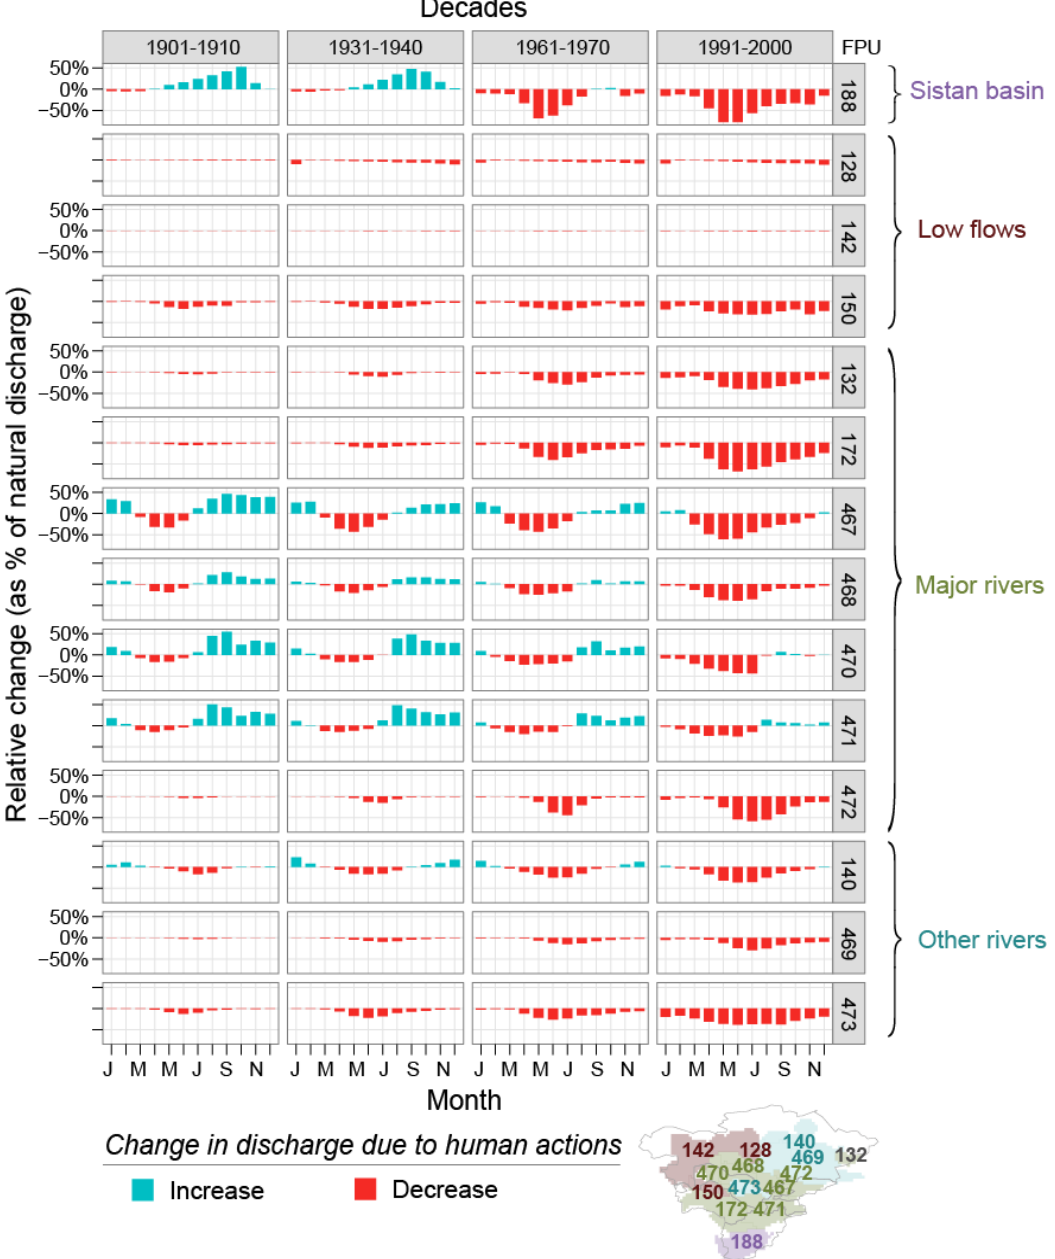
Figure 7. Monthly change in discharge due to human influence, relative to natural discharge, averaged for decades from 1905–2000. Estimated discharge under a natural scenario is subtracted from estimated discharge including human influences, i.e. , with flow regulation and water